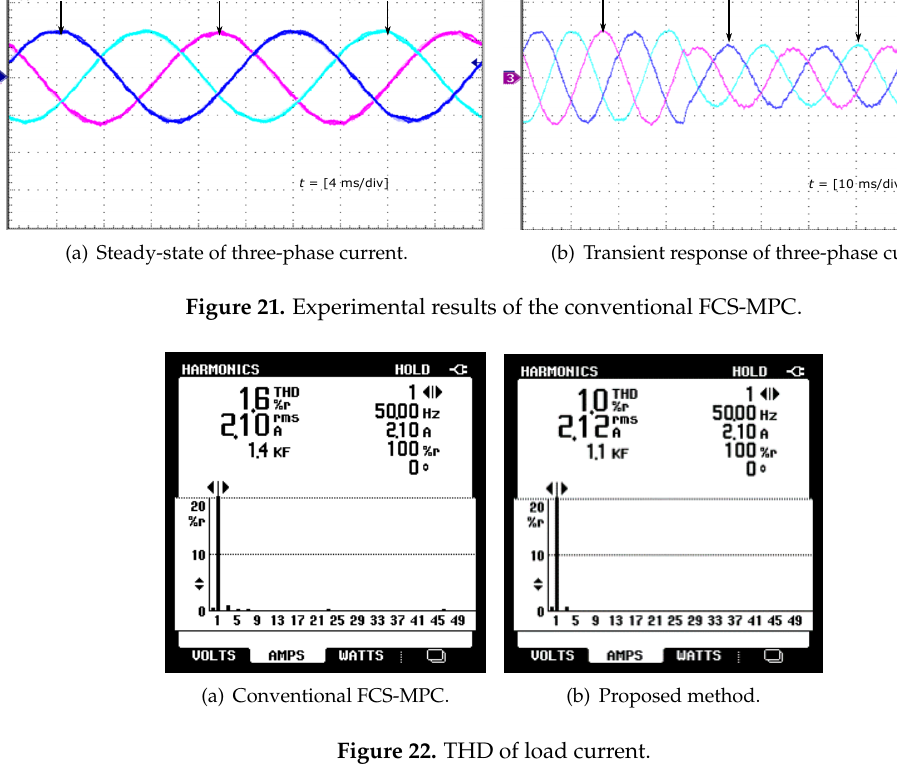
Figure 22. THD of load